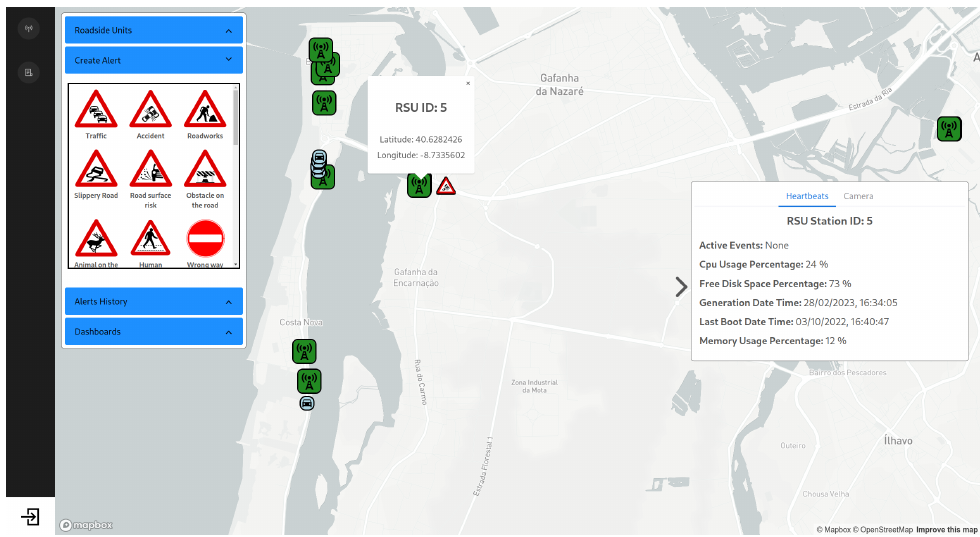
Figure 7. Overview of the STEROID deployment scenario and C-ITS platform. RSUs statuses and nearby traffic perceived by the RSUs radars can be viewed. The C-ITS platform can also generate events and forward them to respective